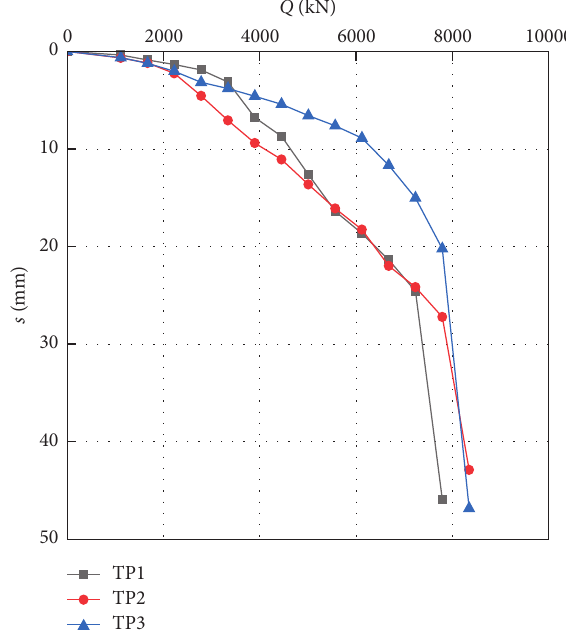
Figure 3: Q-s curves of test piles TP1–TP3.